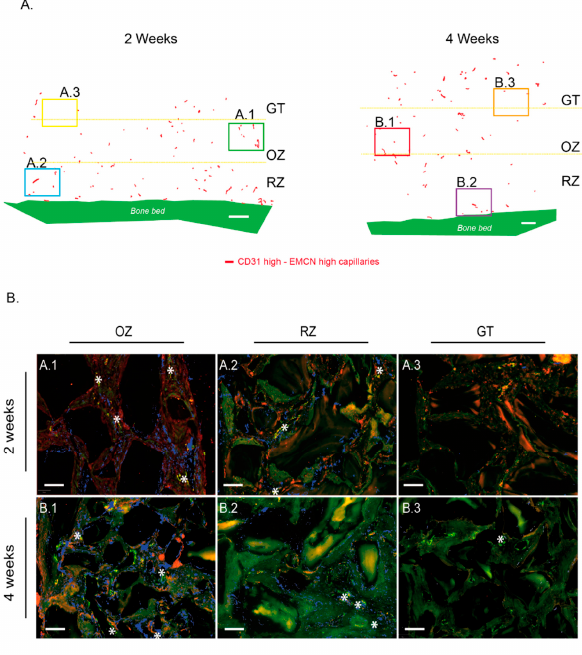
Figure 6. “CD31 High/EMCN High” capillaries distribution within the cylinder contents at 2 and 4 weeks and correlation with the presence of Osterix-expressing osteogenic precursors. ( A ) CD31 High/EMCN High capillaries from a representative image of a cylinder’s entire content at 2 weeks (left) and 4 weeks (right) are shown on a projection where tissues were digitally removed. The same representative sample was conserved from Figures 2A and 3A, and Figure 5D at 2 weeks, Figures 2B and 3B, and Figure 5D at 4 weeks. Granulation tissue (GT), osteogenic zone (OZ), and remodeling zone (RZ) were delimited by yellow dotted lines. White bar: 500 µm. ( B ) Representative magnifica- tions from Figure 6A—cylinder content at 2 weeks: OZ ( A.1 ), RZ ( A.2 ), and GT ( A.3 ) and Figure 6B—cylinder content at 4 weeks: OZ ( B.1 ), RZ ( B.2 ), and GT ( B.3 ). Samples were analyzed by RNA hybridization for CD31 (green), EMCN (red), and OSX (blue). The “CD31 High/EMCN High” capil-